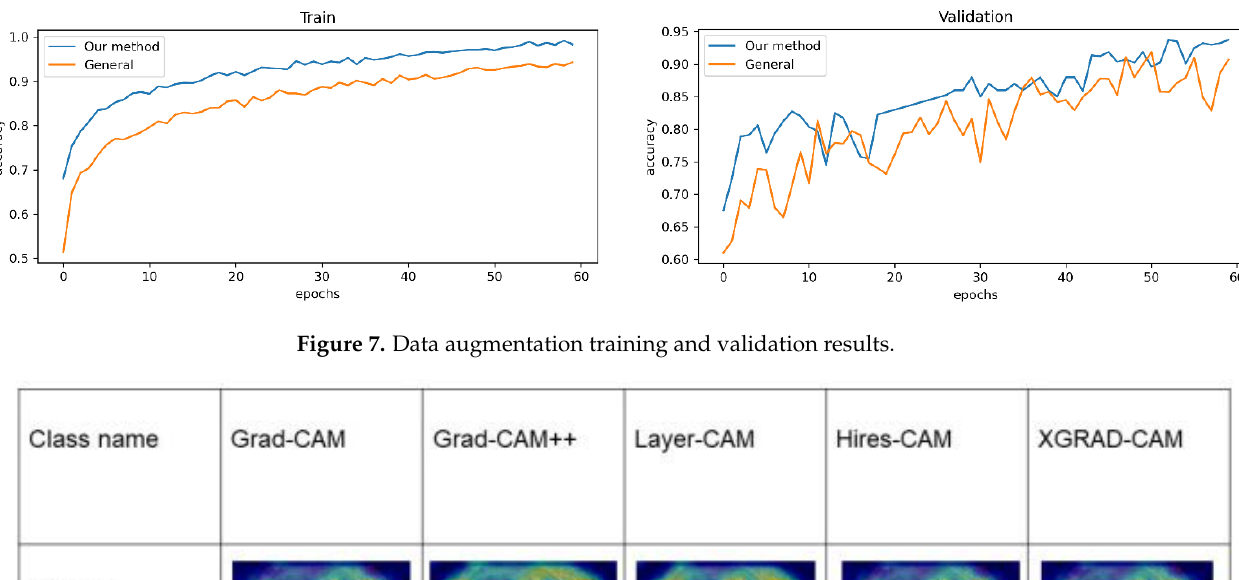
Table 3. Data augmentation method performance .